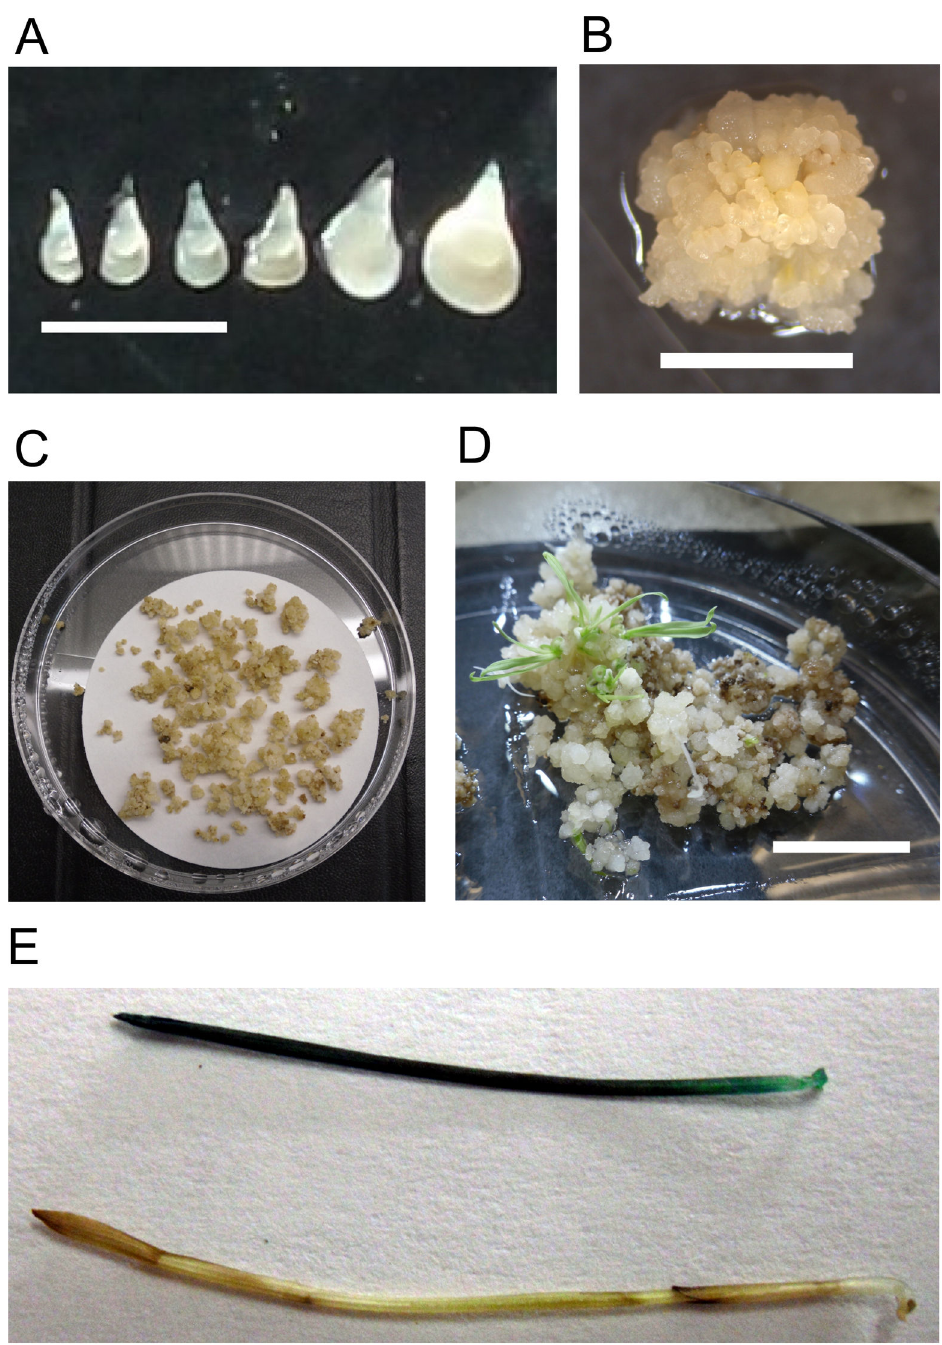
Figure 1. Tissue culture stages of inbred line Ain-1. (a) Embryos dissected from immature seeds. The five embryos on the left will produce high quality embryogenic callus. The embryo on the right is slightly too large. Note that it is also more opaque. The scale bar is 1 mm. (b) Appearance of high-quality embryogenic callus. Note the structures that look like embryos. Scale bar is 5 mm. (c) Callus on dry filter paper after removal from Agrobacterium suspension. The plate is 10 cm in diameter. (d) Transgenic plantlets regenerating from callus. Note the presence of darker non-transgenic callus that is dying. Scale bar is 1cm. (e) GUS positive (top) and negative (bottom) plants representative of the transgenic outcrossed progeny and non-transgenic selfed progeny of the non- transgenic plants used to determine outcrossing frequency.